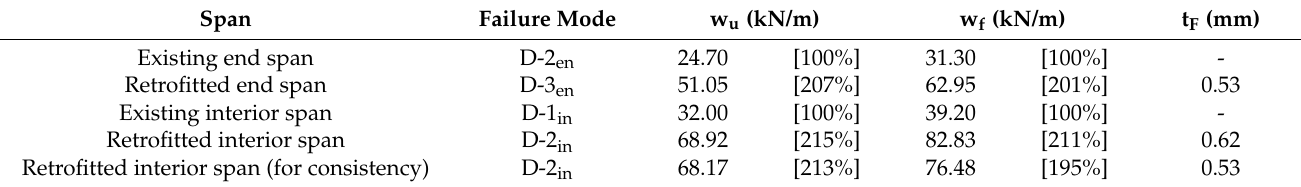
Table 7. Summarize the retrofit results of the strengthened RC